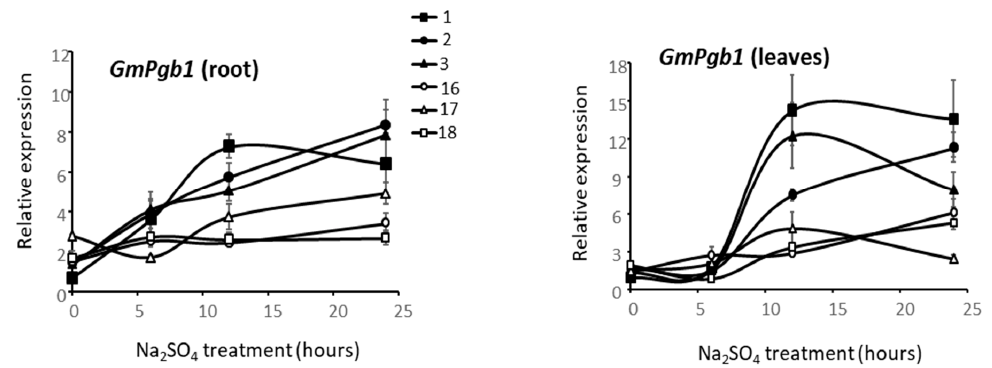
Figure 8. Expression level of GmPgb1 in roots and leaves of commercial soybean cultivars exposed to Na 2 SO 4 . Cultivars were denoted as tolerant (1, 2, 3) or susceptible (16, 17, 18) to Na 2 SO 4 stress. Values are the means ± SE of three biological replicates, each consisting of at least three plants.